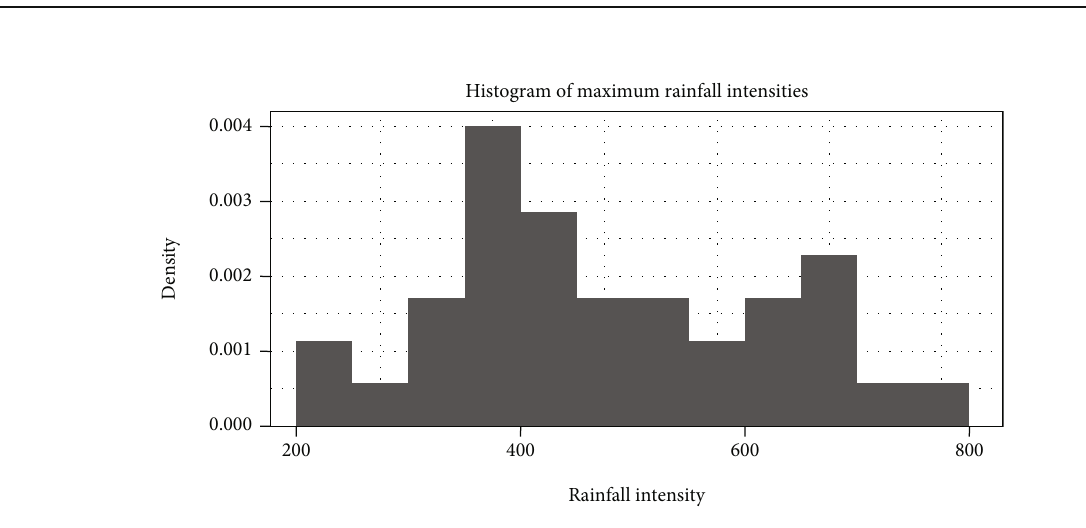
Figure 4: Graph of maximum rainfall intensities in Port Harcourt, Rivers States.